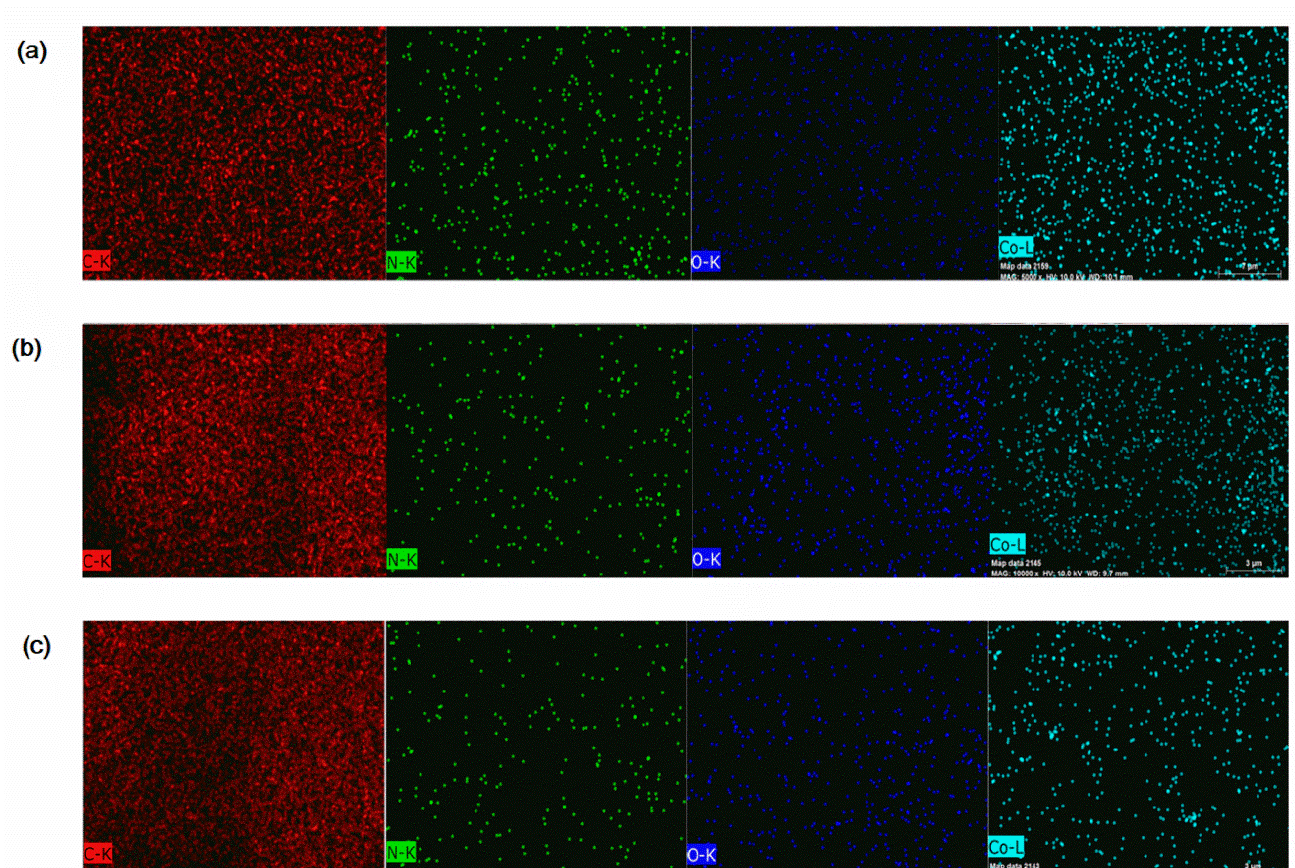
Figure 6. EDS mappings of Co, N, C, and O elements of ( a ) CoNC-800A-700, ( b ) CoNC-900A-800, and ( c ) CoNC-1000A-900 .